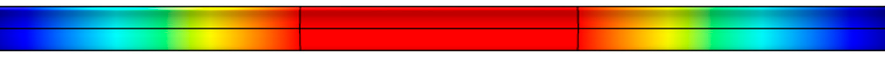
Figure 11. Electric field intensity distribution.